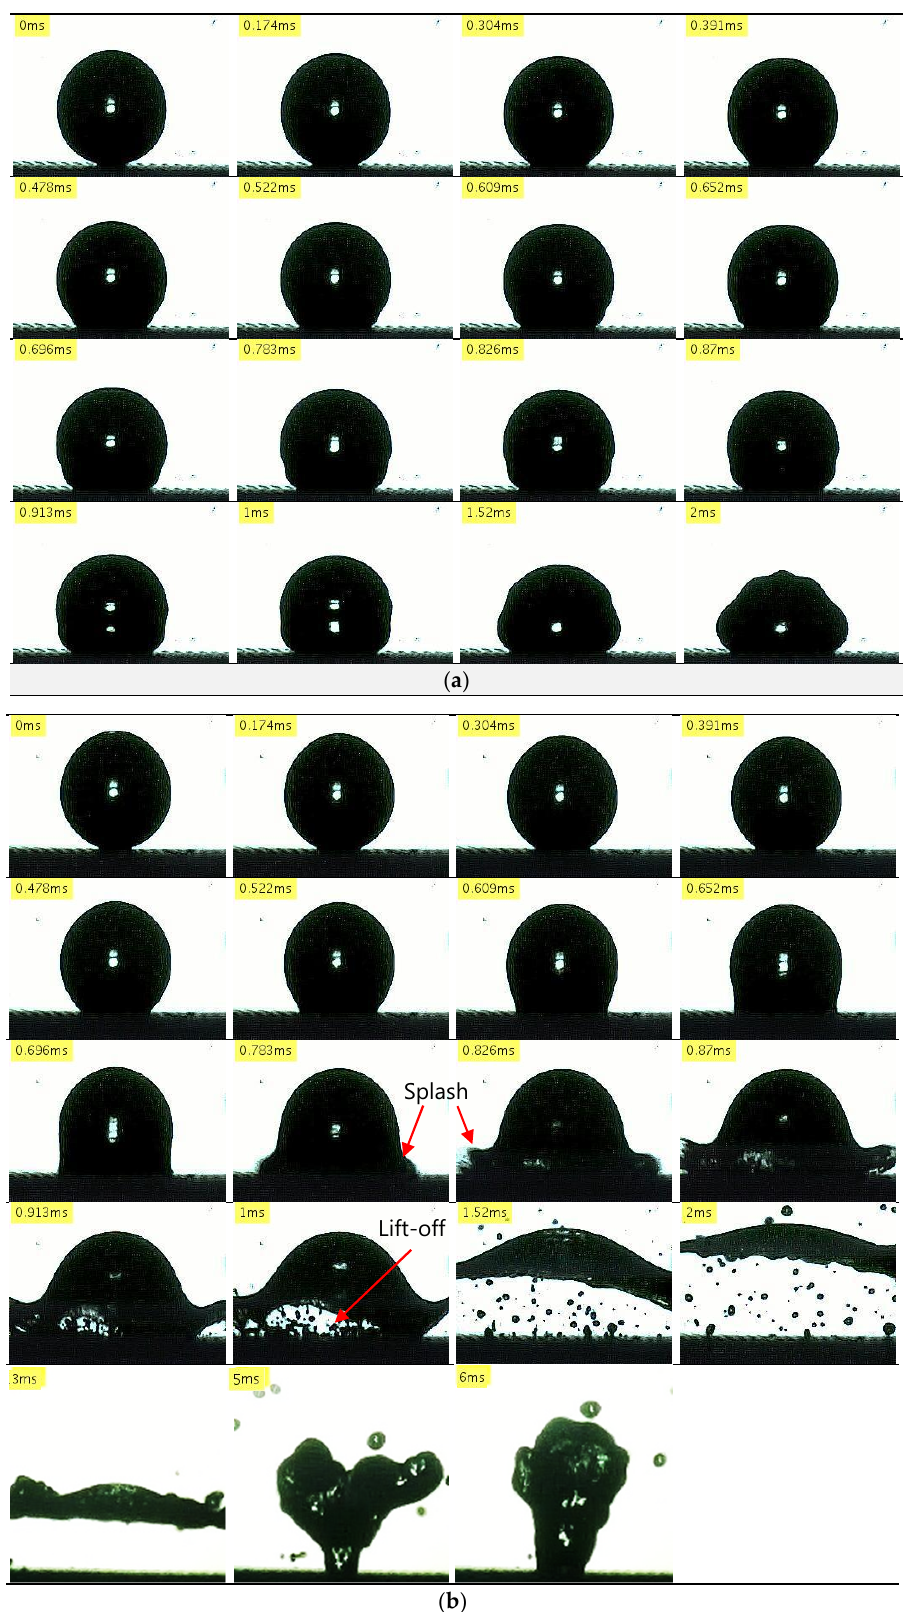
Figure 13. Sequential images of drop impact on ( a ) #120 and ( b ) nano-#120 mesh surfaces at T s ≈ 335 °C. Frame rate is 23,000 fps. Scale bar is 1 mm.